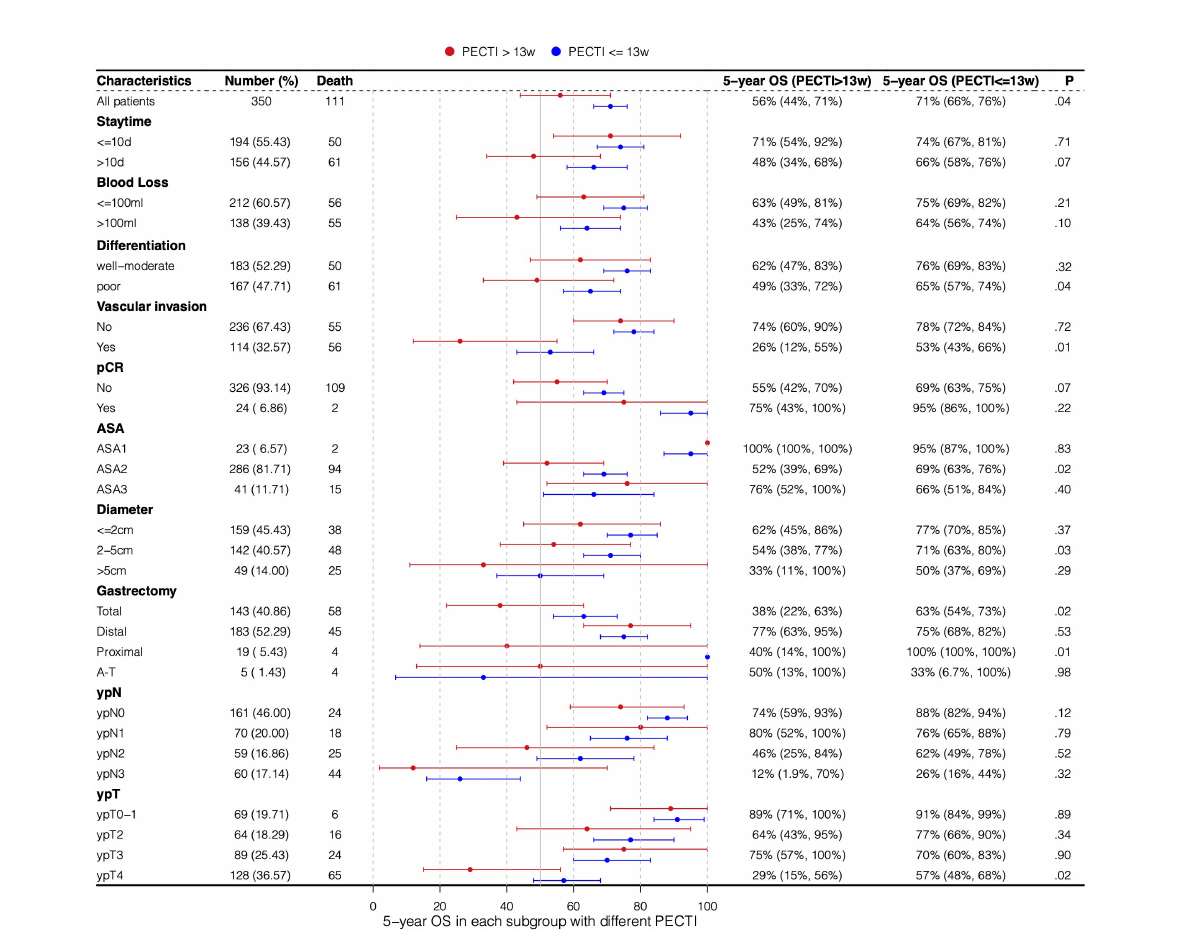
FIGURE 5 Subgroup analyses by forest plot based on 5-year survival rate. Plot showing the 5-year survival rate of the population experiencing PECTI within or over 13 weeks. PECTI, perioperative chemotherapy time interval; OS, overall survival; pCR, pathological complete response; ASA, American Society of Anesthesiologists; AT, abdominal-thoracic